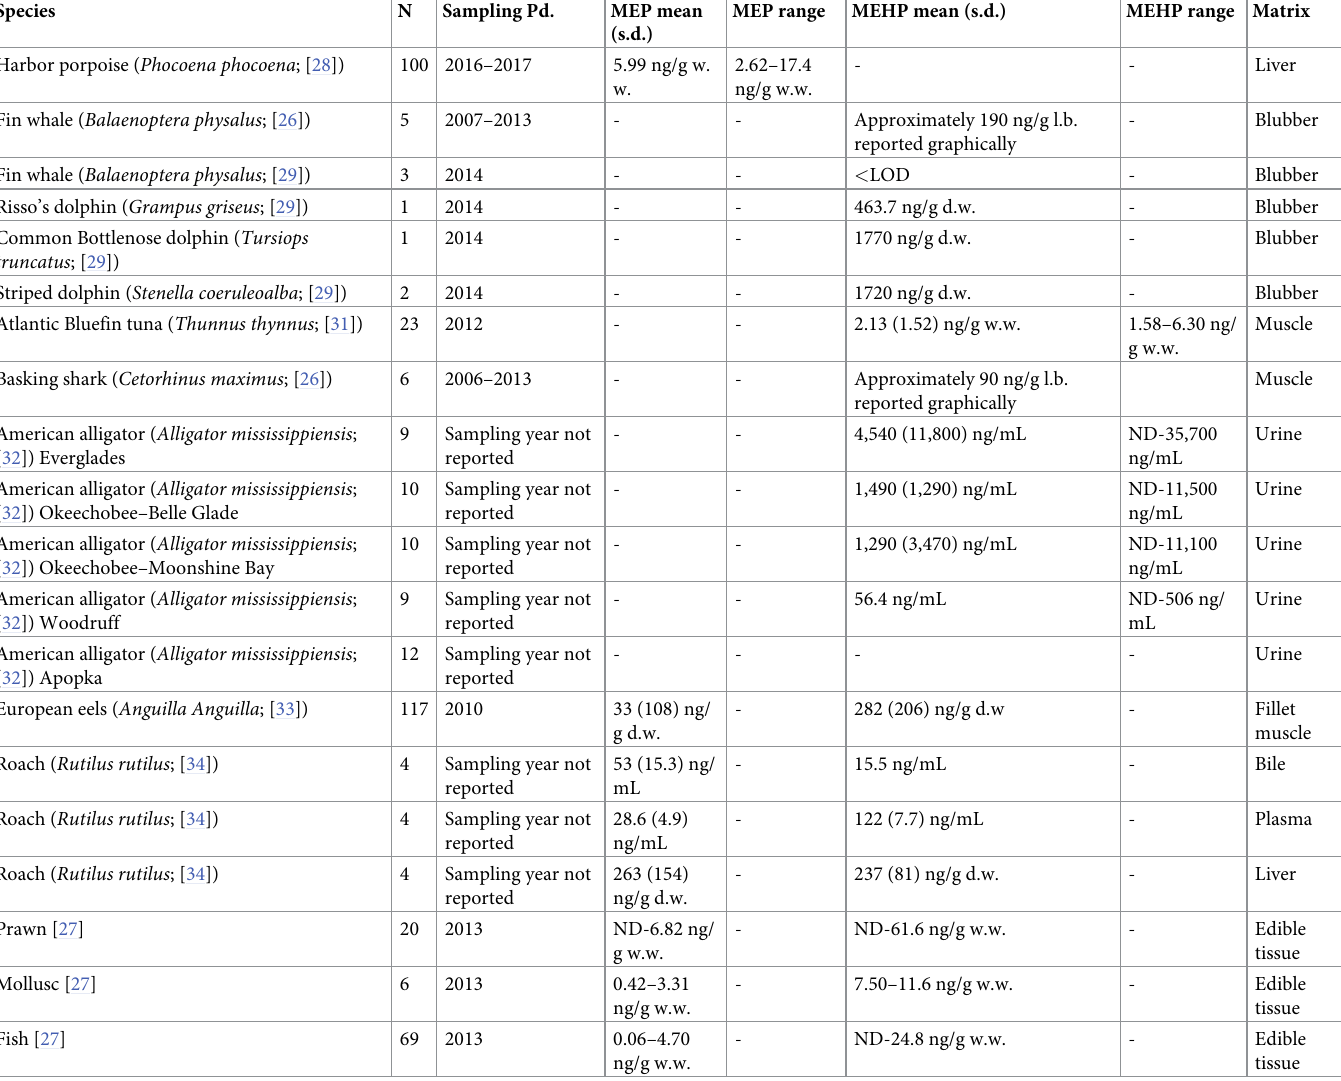
Table 1. Mean concentrations (solid mass reported as wet weight (w.w.) or dry weight (d.w.)) of monoethyl phthalate (MEP) and mono-(2-ethylhexyl) phthalate (MEHP) with corresponding ranges and standard deviations as reported in varying matrices from other marine species. Species